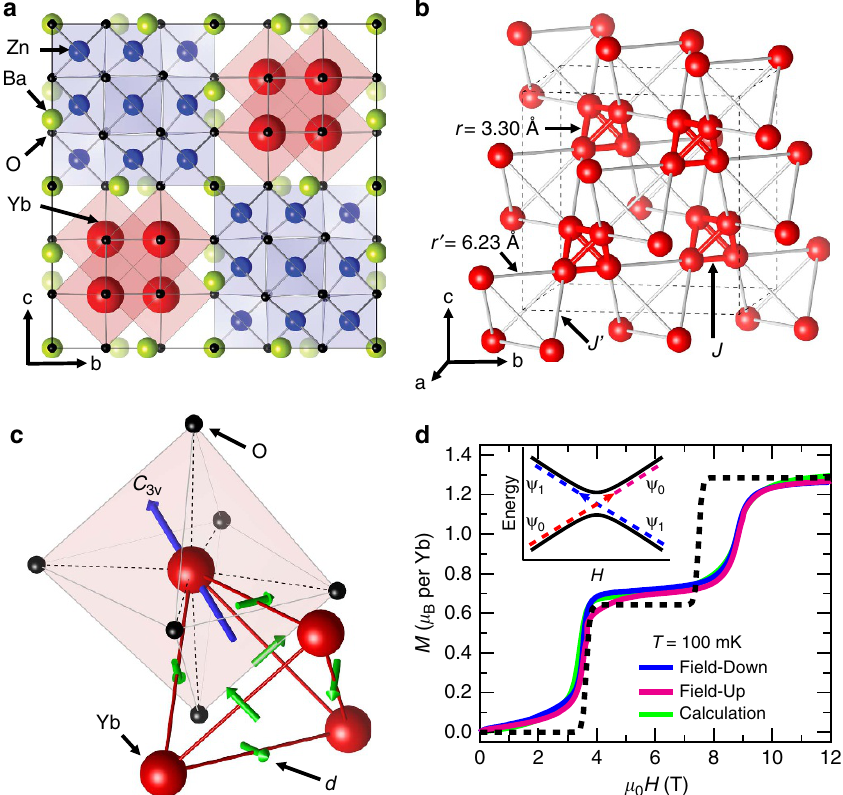
Figure 1 | Crystallographic structure and magnetization curves of Ba 3 Yb 2 Zn 5 O 11 . ( a ) Crystal structure of pyrocholre Ba 3 Yb 2 Zn 5 O 11 with cubic space group F (cid:2) 43 m . Green, red, blue and black spheres represent Ba, Yb, Zn and O ions, respectivley. Two main blocks of Yb 4 O 16 and Zn 10 O 20 are alternated and Ba ions locate in the interstices. ( b ) Arrays of Yb ions and Yb 4 tetrahedrons with alternated Yb–Yb distances in the breathing pyrochlore structure. The inter-tetrahedron (red line) and intra-tetrahedron (grey line) Yb–Yb distances are r ¼ 3.30Å and r 0 ¼ 6.23Å, respectively. Correponding magnetic exchange couplings are denoted by J and J 0 . ( c ) Yb 4 tetrahedron and YbO 6 octahedron with trigonal distortion ( C 3v ). A blue arrow denotes C 3v symmetry axis pointing along the [1 1 1] direction and green arrows indicate the DM vectors d ’s determined from the Moriya’s rule. ( d ) Field-dependent magnetization M ( H ) measured for upfield (magenta) and downfield (blue) sweeps with a rate of 15mTmin (cid:2) 1 at T ¼ 100mK, showing the level crossing critical fields of H C1 ¼ 3.5T and H C2 ¼ 8.8T. A green solid line displays adiabatic simulation results from H eff with J ¼ 0.589meV, d / J ¼ 0.27, g || ¼ 3.0 and g > ¼ 2.4. A black dashed line displays simulation results at T ¼ 100mK with H C1 ¼ 3.7T and H C2 ¼ 7.4T from the conventional Heisenberg magnetic exchange Hamiltonian including the Zeeman term with an exchange coupling constant J ¼ 0.554meV and an isotropic g -factor g ¼ 2.569 reported previously 24 . The inset is a schematic illustration of Landau (cid:2) Zener transition between two energy states of c 0 and c 1 as in Fig. 2d. Adiabatic and non-adiabatic processes as a function of the external magnetic field are presented with solid and dashed lines,